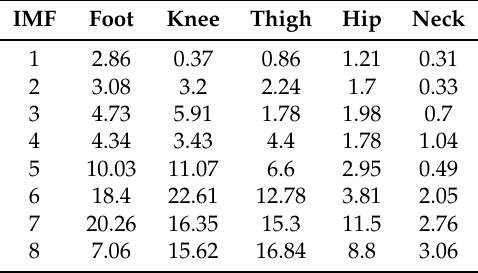
Table 4. The instantaneous amplitude (deg) of each decomposed IMF and its trend at the landing impact.